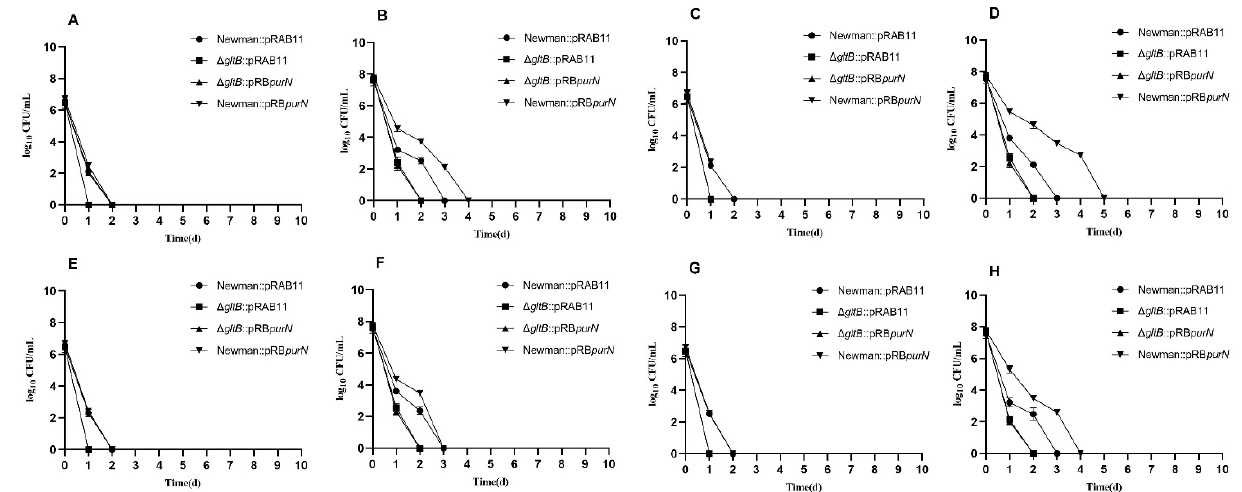
Figure 5. Antibiotics exposure results of Newman::pRAB11, ∆ gltB ::pRAB11, ∆ gltB ::pRBpurN and Newman::pRBpurN to ampicillin ( A , B ), levofloxacin ( C , D ), gentamicin ( E , F ) and vancomycin ( G , H ) at different culture times. 5-h culture ( A , C , E , G ); 9-h culture ( B , D , F , H ).